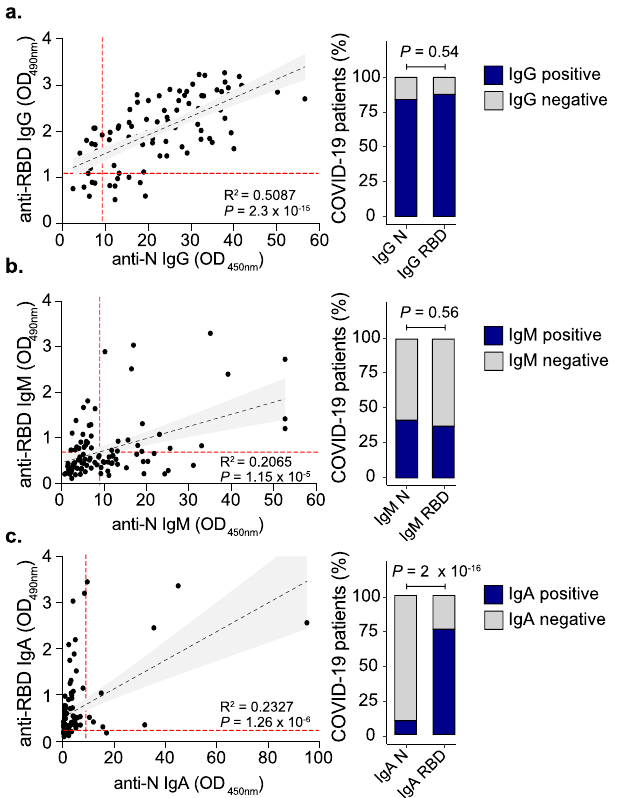
Figure 2. Isotype composition of SARS-CoV2 convalescent serum. Anti-RBD and anti-N ELISA correlation for IgG ( a ), IgM ( b ) and IgA ( c ). Left panels: correlations and linear regressions comparing anti-RBD and anti-N for each antibody isotype (N = 101). Analyses were performed using GraphPad Prism 8. P values were calculated using a two-sided F test. The red dashed lines indicate the threshold (anti-N ELISA for -IgG, -IgM or -IgA are OD450nm = 9; anti-RBD ELISA for -IgG is OD490nm = 1.091; -IgA is OD490nm = 0.256 and -IgM is OD490nm = 0.694) for each ELISA. Right panels indicate the percentage of COVID-19 PCR-positive patients that are positive (blue bars) or negative (gray bars) for IgG ( a ), IgM ( b ) or IgA ( c ). P values were calculated using two-sided Fisher’s exact